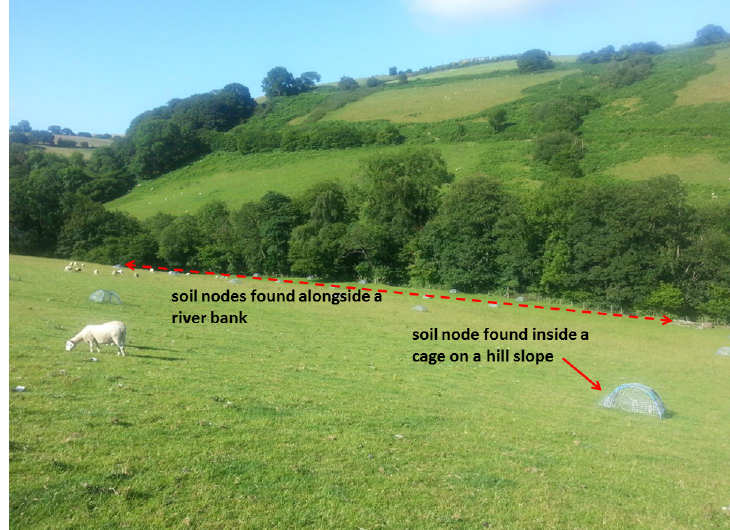
Figure 13. Hierathlyn field deployment site.